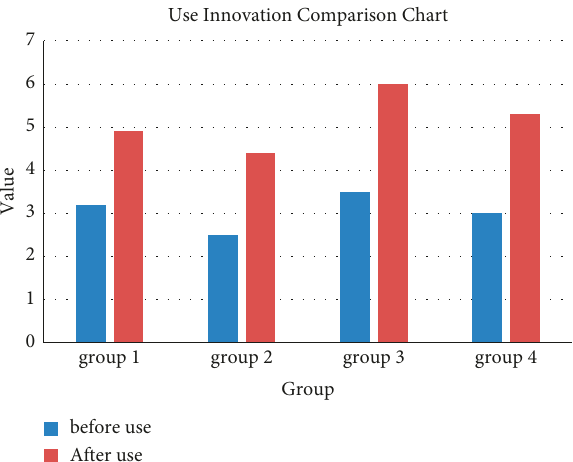
Figure 2: Innovative experimental analysis of the transportation process of